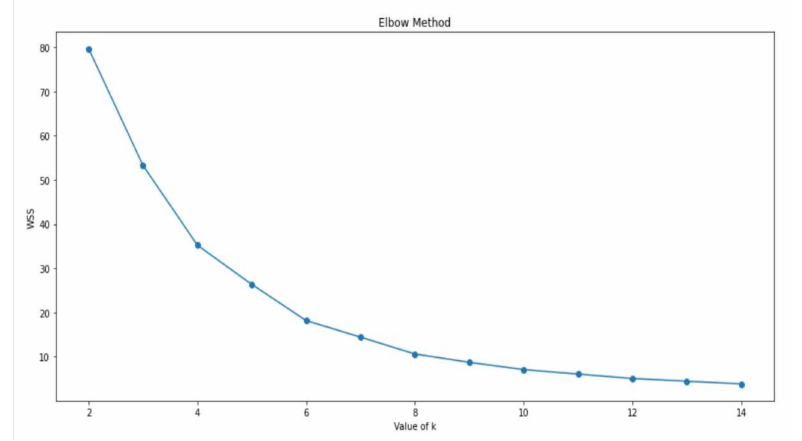
Figure 10. Optimal k Value based on Elbow Method.